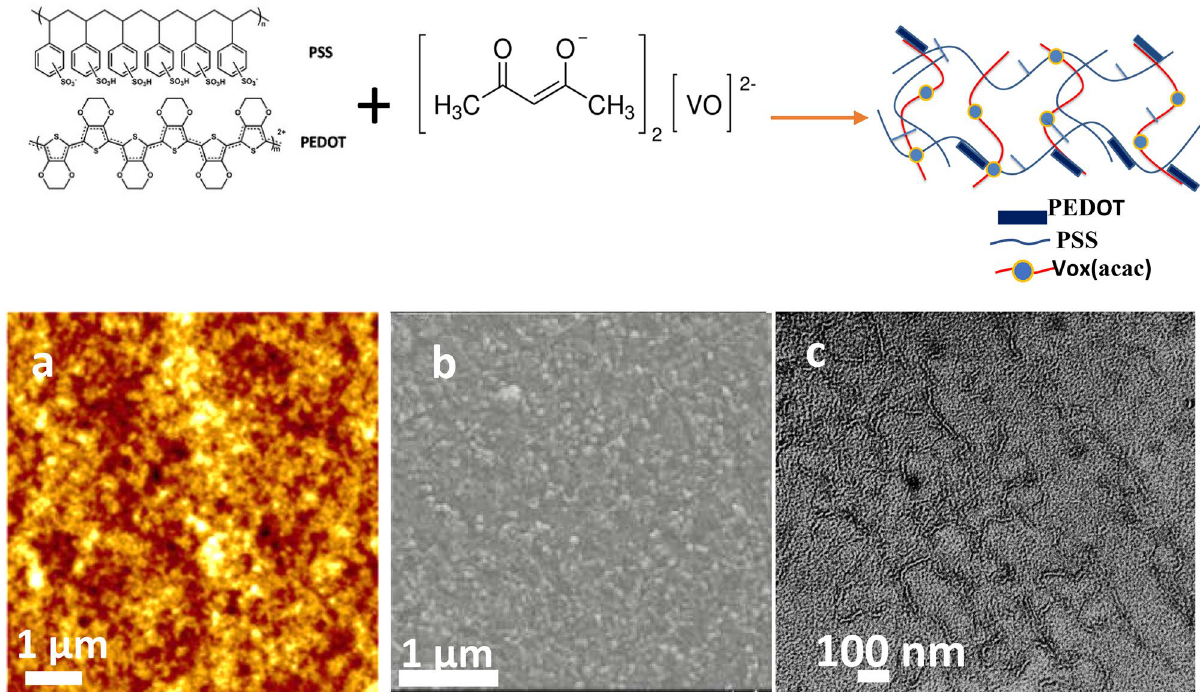
Figure 8. Schematic illustration of the formation of the interpenetrating networks by mixing PEDOT-PSS with VOx(acac). AFM ( a ), SEM ( b ) and TEM ( c ) images of the PEDOT-PSS:VOx (1:3) printed film.